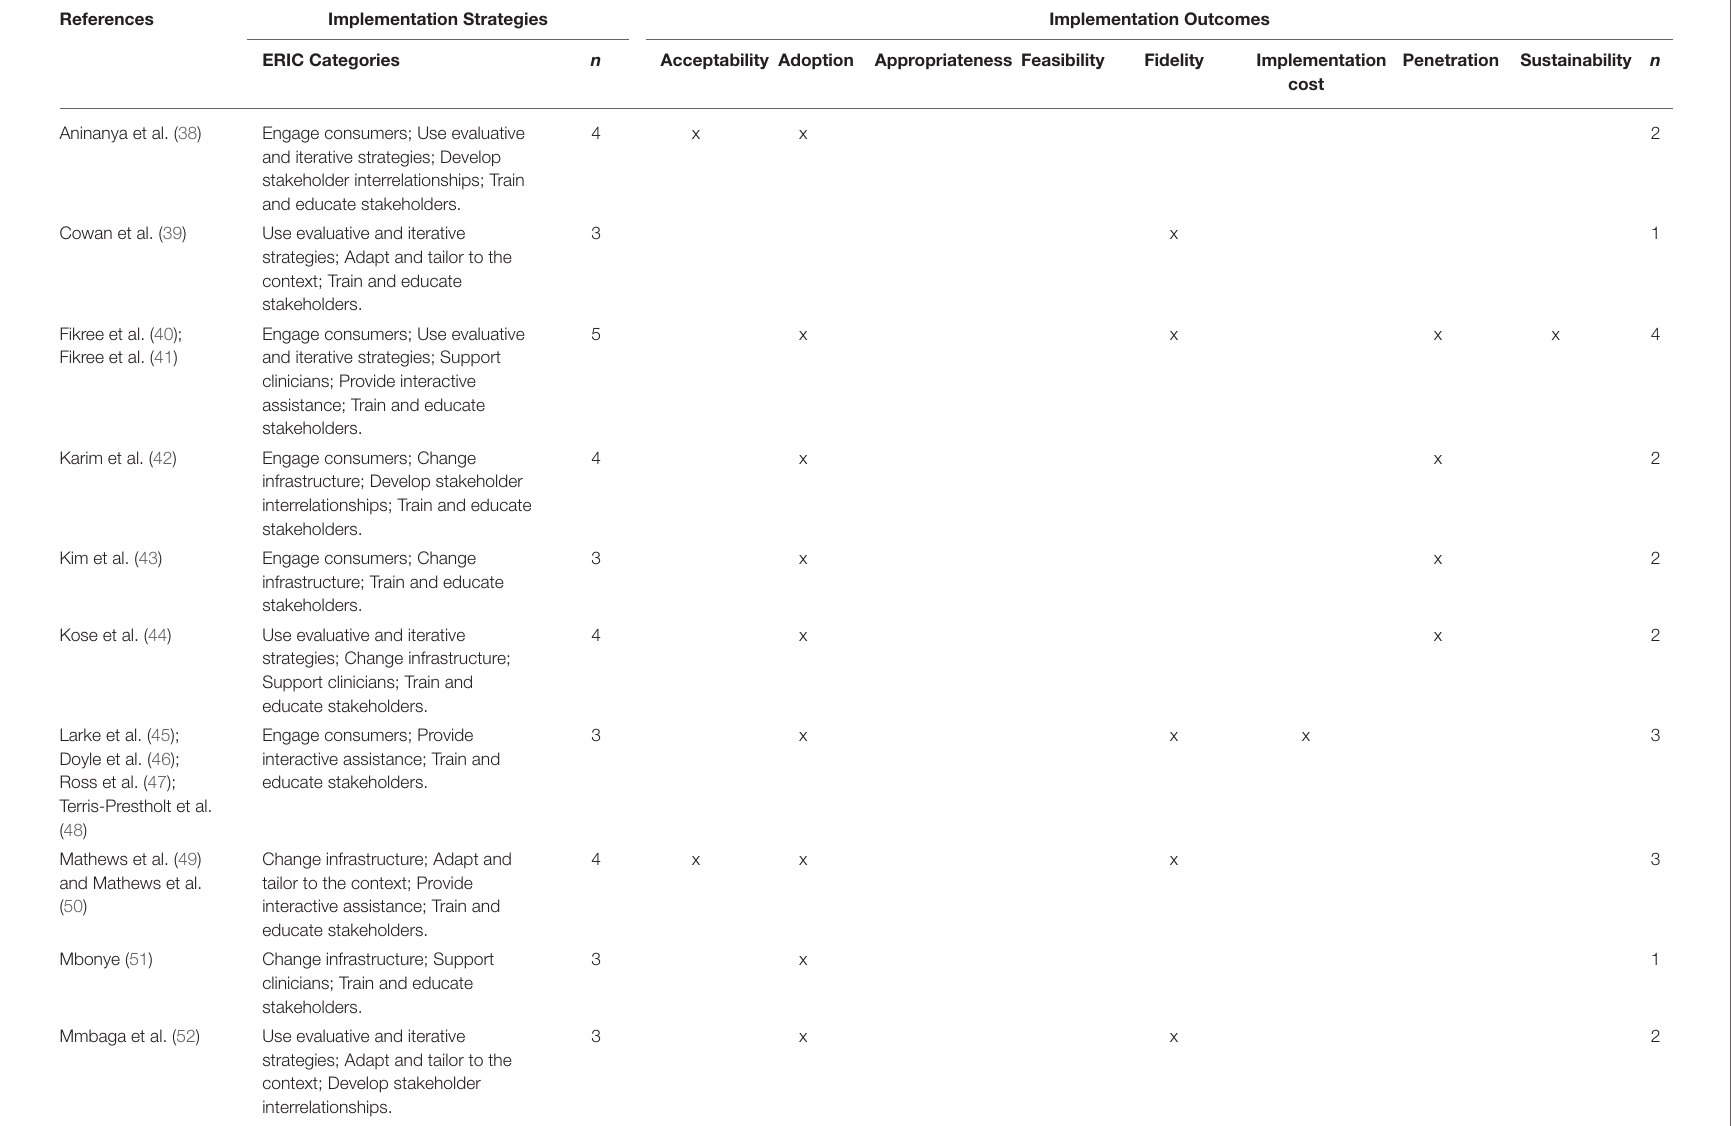
TABLE 3 | Implementation strategies used and implementation outcomes reported in the included